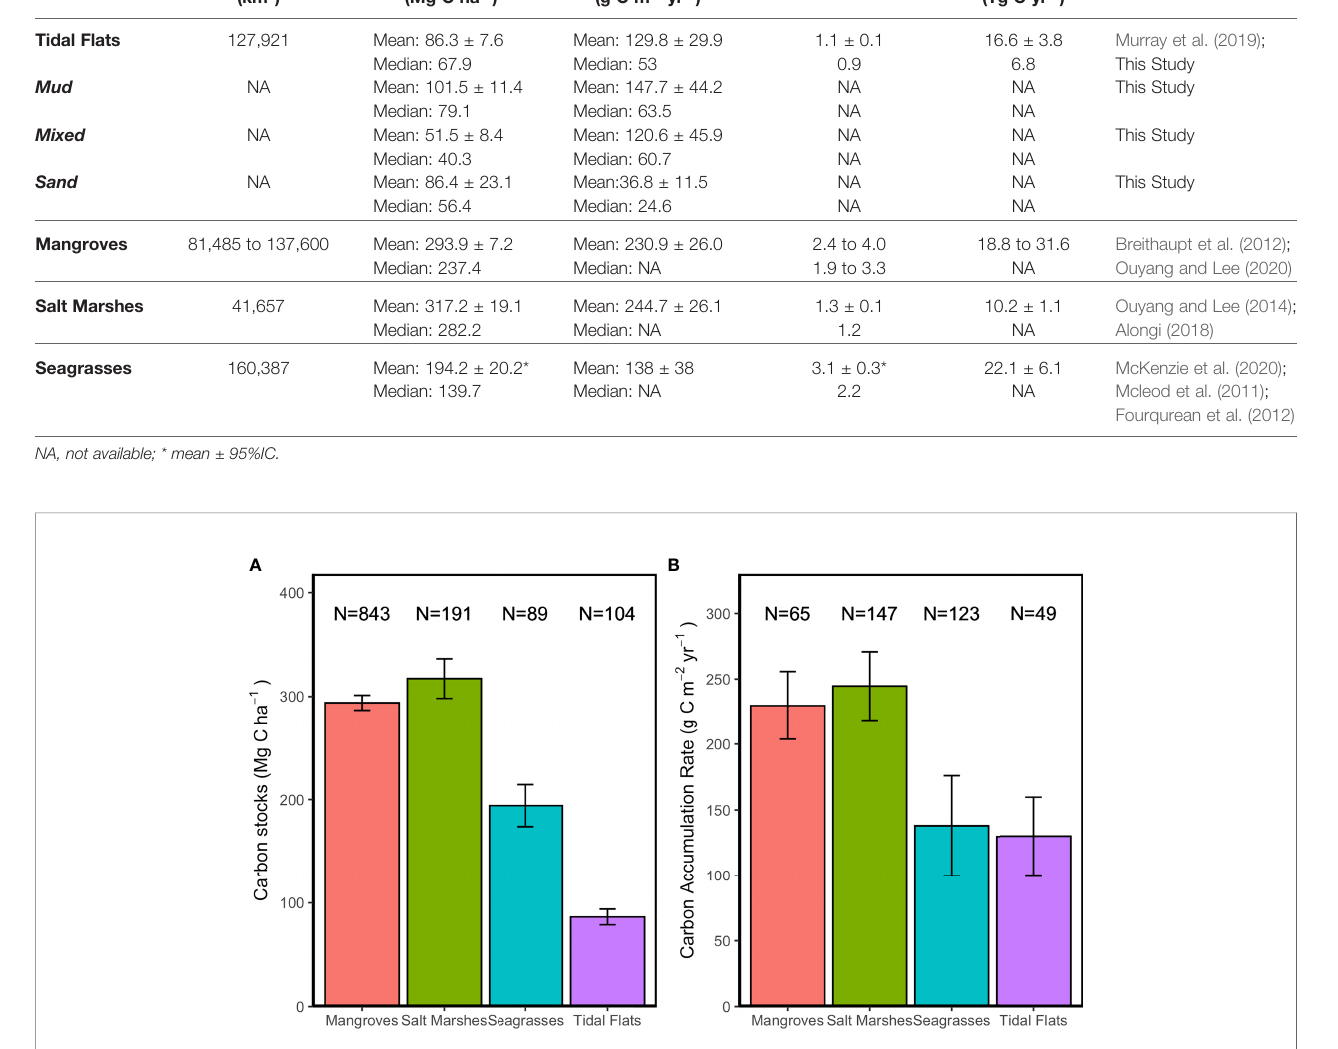
TABLE 1 | Comparison of rate of tidal fl at C sequestration (mean ± SE) estimated in this study with other published data on vegetated coastal wetlands.